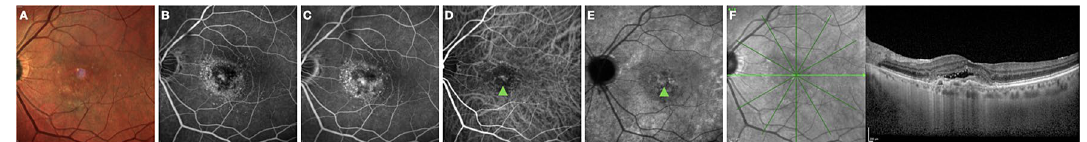
Figure 1. Images from a patient with a type 1 macular neovascularization secondary to age-related macular degeneration. ( A ) Multicolor image demonstrates regions of retinal pigment epithelium changes in the macular area. ( B , C ) Early- and late-phase fluorescein angiography (FA) images displays hyperfluorescent areas with leakage. ( D , E ) Early- and late-phase indocyanine green angiography (ICGA) show macular hyperfluorescence (highlighted with green head arrows) with late staining. ( F ) A fibrovascular pigment epithelial detachment associated with subretinal fluid and hyperreflective material is detected with structural